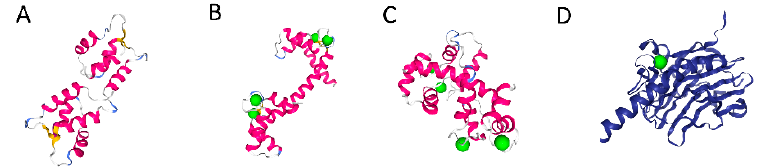
Figure 2. Ca 2+ binding by structured motifs of calmodulin and calreticulin. Calcium ions in green. ( A ) Calmodulin without calcium (well-structured), PDB_1CFC ( B ) Calcium-bound calmodulin, PDB_1UP5. The structure has changed, but remains well-ordered. ( C ) Calmodulin bound to a fragment of calcineurin PDB_2JZI. ( D ) Globular domain of calreticulin containing a single, high-affinity Ca 2+ binding site, PDB_3POW.